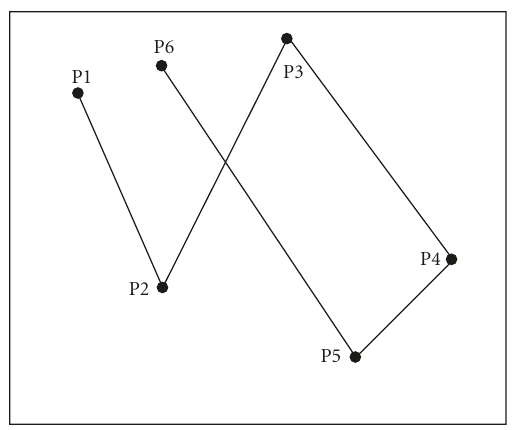
Figure 2: Example of node movement in the Random Waypoint